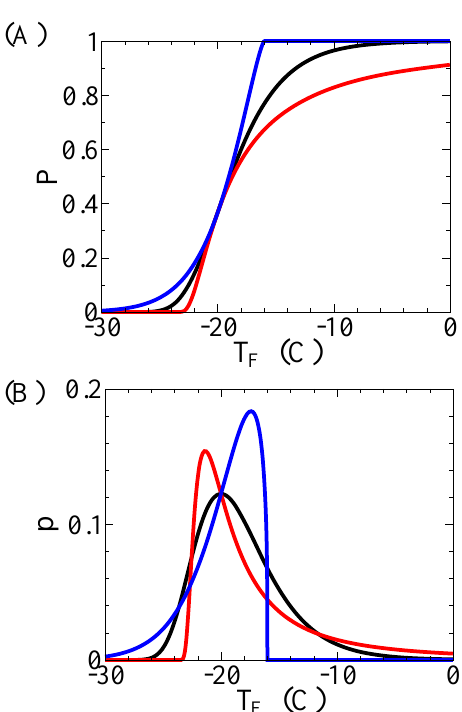
Fig. 2. (A) Plot of the scaling of the median freezing temperature, T MED , with the number of nucleation sites, N . The black curve is the ln N scaling that is consistent with the Gumbel distribution. It is a plot of the T MED of Eq. (7), with parameters s = 10 − 8 and w e = 3 ◦ C. The red curve is the N 3 / 4 scaling that is consistent with the Fr´echet distribution with ξ = 0 . 75. It is a plot of the T MED of Eq. (16), with parameters b = 2 × 10 − 5 and T L = − 25 ◦ C. The blue curve is the N − 3 / 4 scaling that is consistent with the Weibull dis- tribution with ξ = − 0 . 75. It is a plot of the T MED of Eq. (17), with parameters c = 10 − 5 and T U = − 15 ◦ C. (B) Plot of cumulative dis- tribution functions for the nucleation temperatures, T n , at the nucle- ation sites. We plot 1 − P 1 (T n ) , i.e. the probability that a nucleation site has a nucleation temperature above T n . This tends to 0 not 1 at high T . The black, red and blue curves are 1 − P 1 s that yield Gum- bel, Fr´echet, and Weibull distributions, respectively. Values of the parameters are the same as in (A)